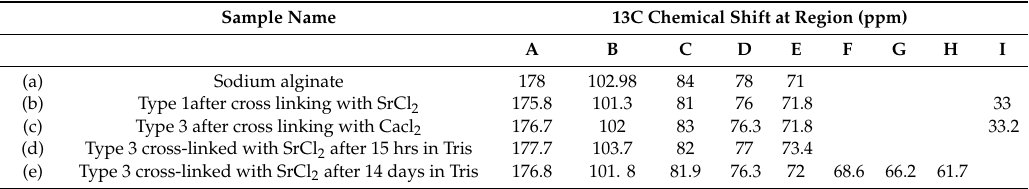
Table 6. Assignments of the resonances in the 13C CP-MAS-NMR spectrum